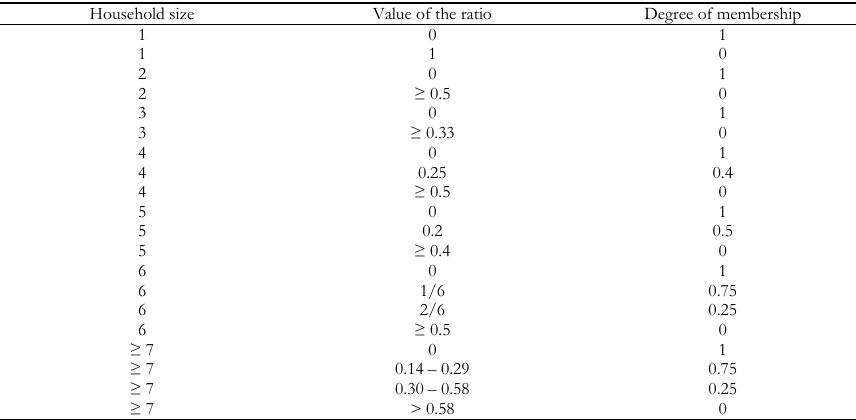
Ratio between the number of the household members perceiving an income and the household size Household